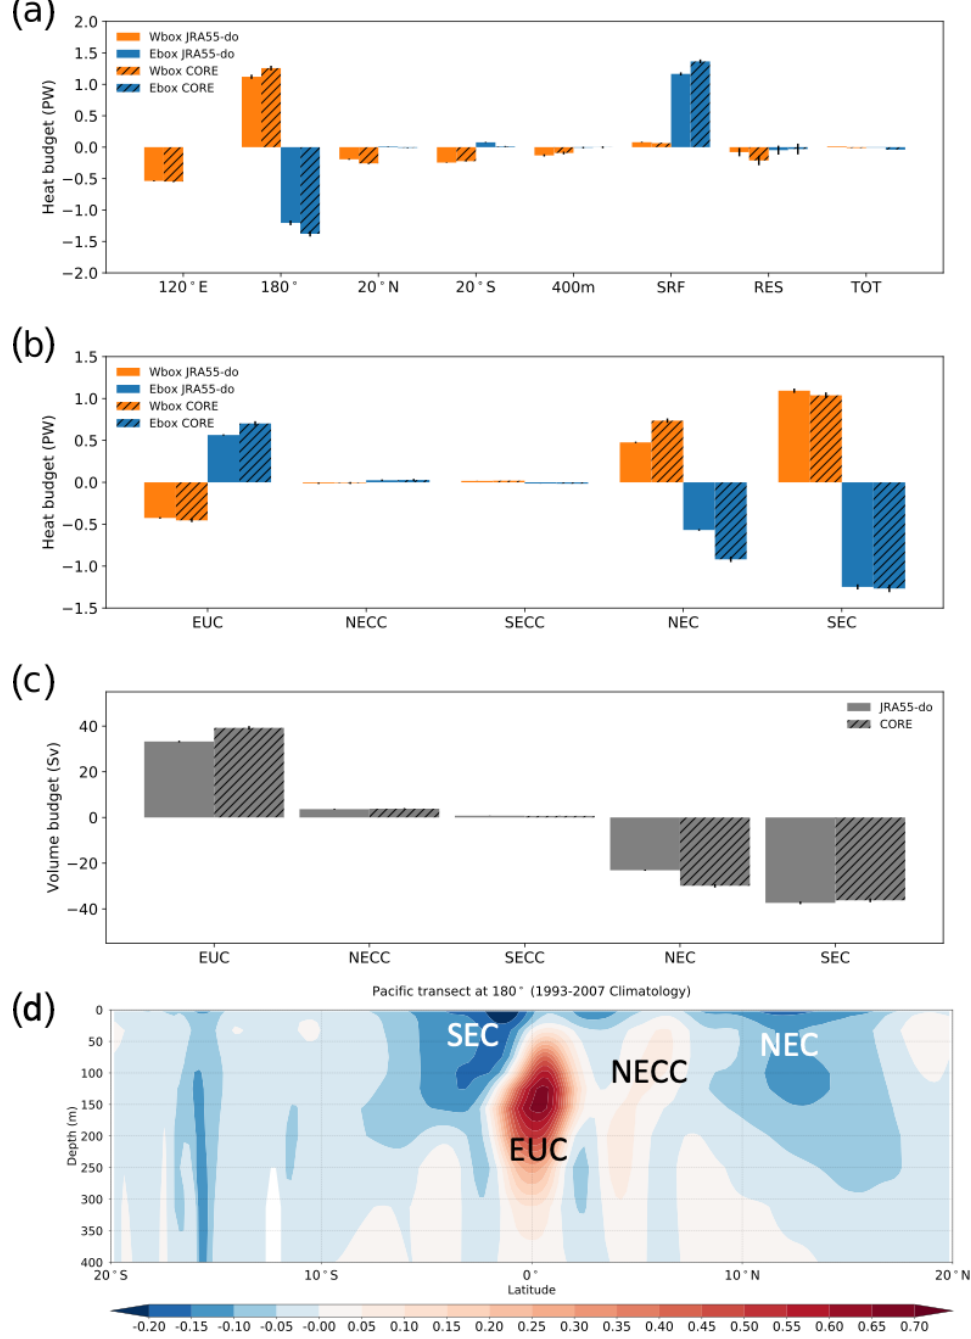
Figure 6. The 1993–2007 time-mean (a) heat contribution from advection across different transects (120 ◦ E, 180 ◦ , 20 ◦ S, 20 ◦ N, 400m), surface flux (SRF), and the residual processes calculated as the difference between the total heat content tendency in the box (TOT) and the sum of SRF and heat advection from all boundaries. The filled yellow and blue bars represent Wbox and Ebox, respectively. The JRA55-do- (no stripe) and CORE-forced (with stripes) simulations are shown side by side for comparison. The mean state of the individual current system contributing to the (b) heat budget through heat advection and (c) the associated volume transport across 180 ◦ transect are shown. The error bar shows the 99% confidence interval of the mean value. Panel (d) shows the mean zonal velocity from the JRA55-do simulation at 180 ◦ transect in the tropical Pacific where positive means eastward velocity. The text shows each defined current